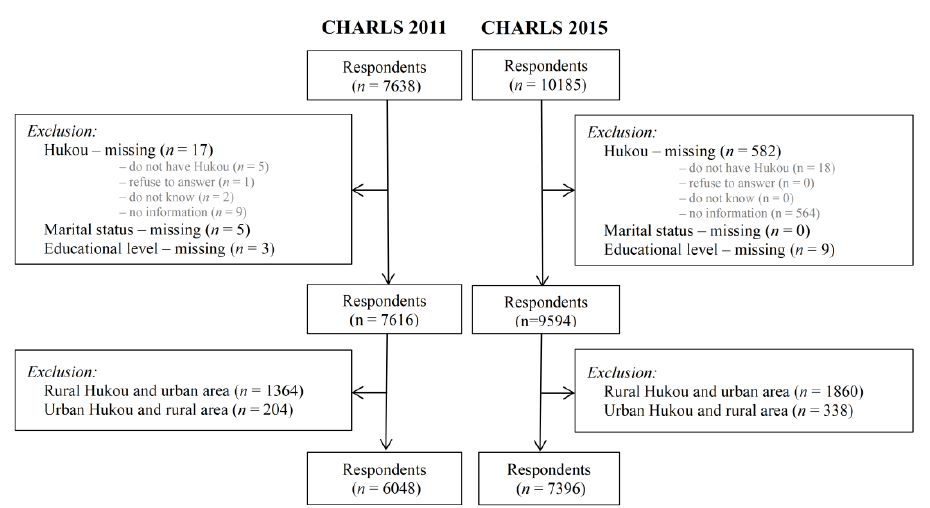
Figure 1. Flow diagram of samples, CHARLS (China Health and Retirement Longitudinal Study) 2011 and CHARLS 2015.